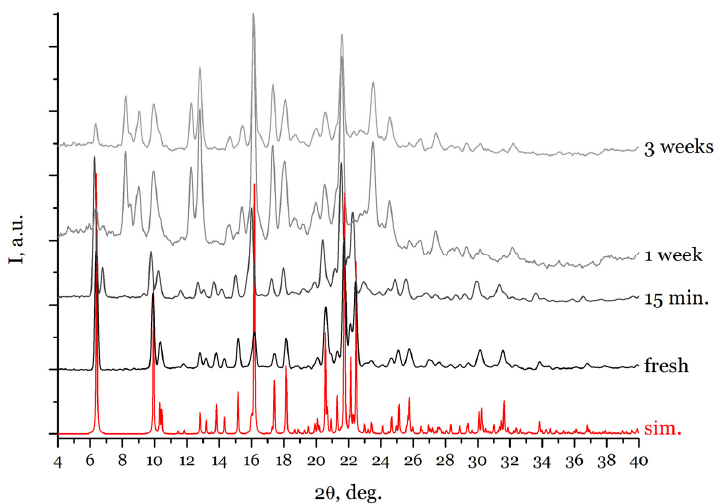
Figure 1. Simulated and experimental powder XRD patterns (Cu K α radiation, 150 K) for pristine compound 2 β ·thf upon aging for 15 min, 1 week, and 3 weeks, which gradually transforms into the solvate-free phase, 2 β .